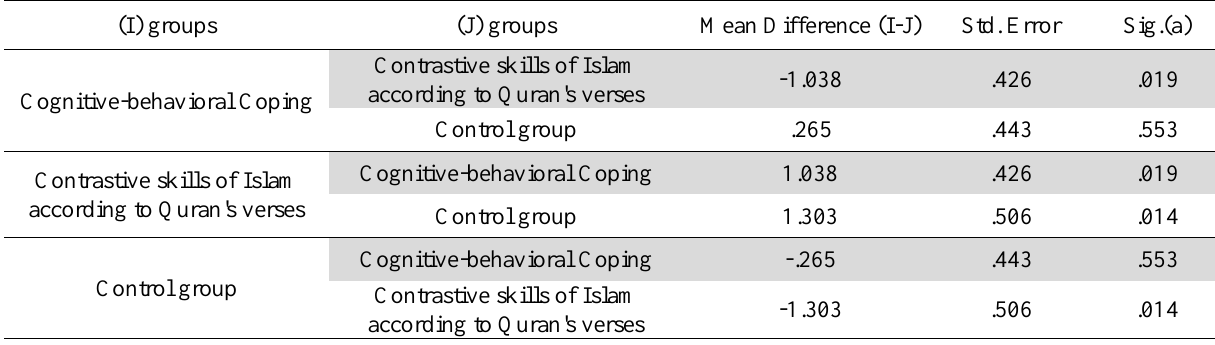
The results of the level of anxiety after follow up (I)